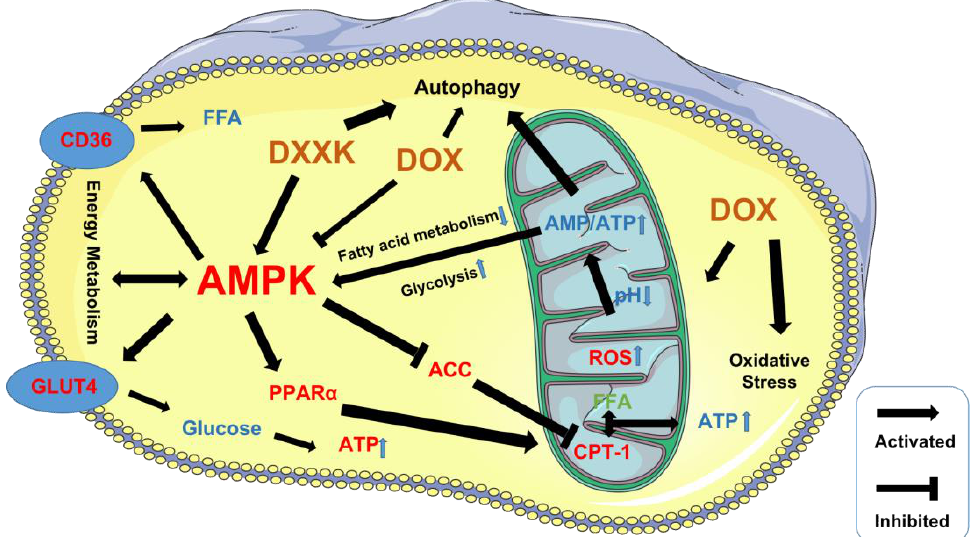
Figure 9. The mechanism of energy damage of cardiac myocytes induced by DOX and energy protection of DXXK.